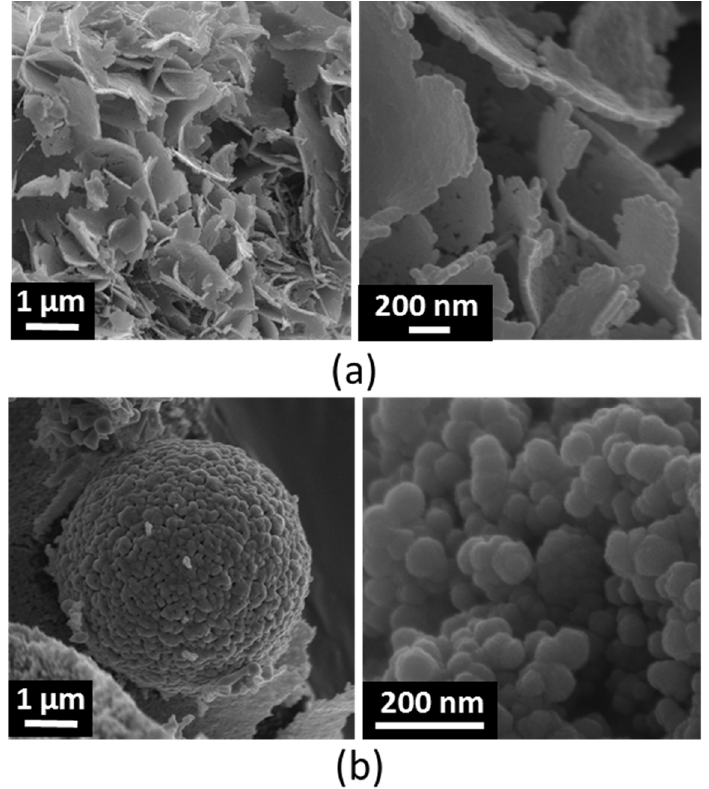
Figure 2. FESEM images of nanostructured (Ns)ZnO-1 ( a ) and NsZnO-2 ( b ).